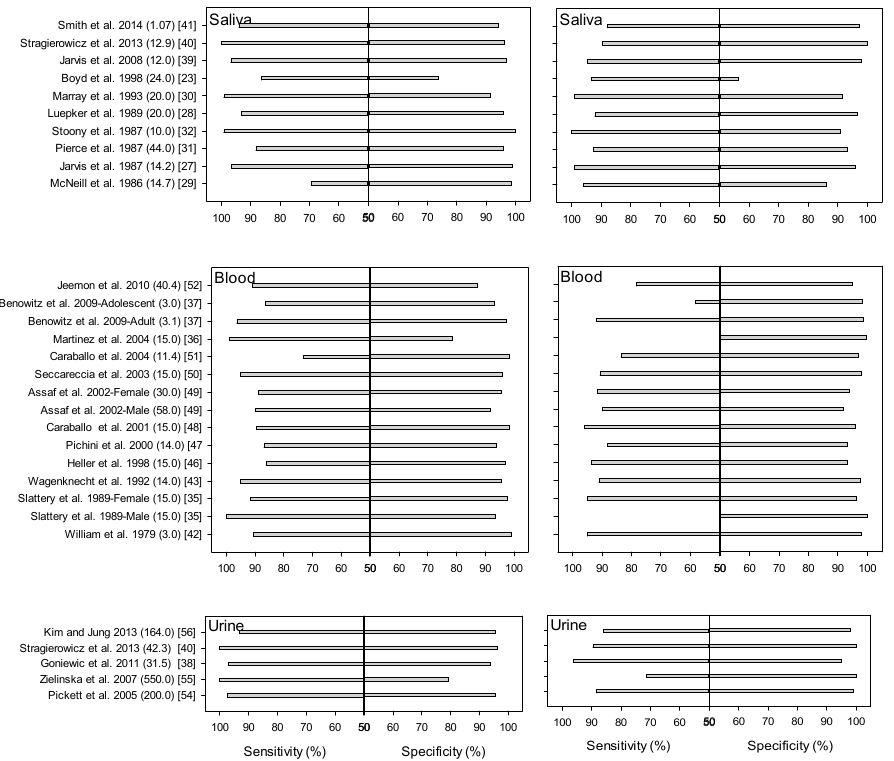
Figure 1. Plots of sensitivities and specificities according to the cutoff values of salivary or serum cotinine. (The numbers in parentheses represent cutoff values and citation number). Gold Standard: Self-Report (Left); Cotinine (Right).